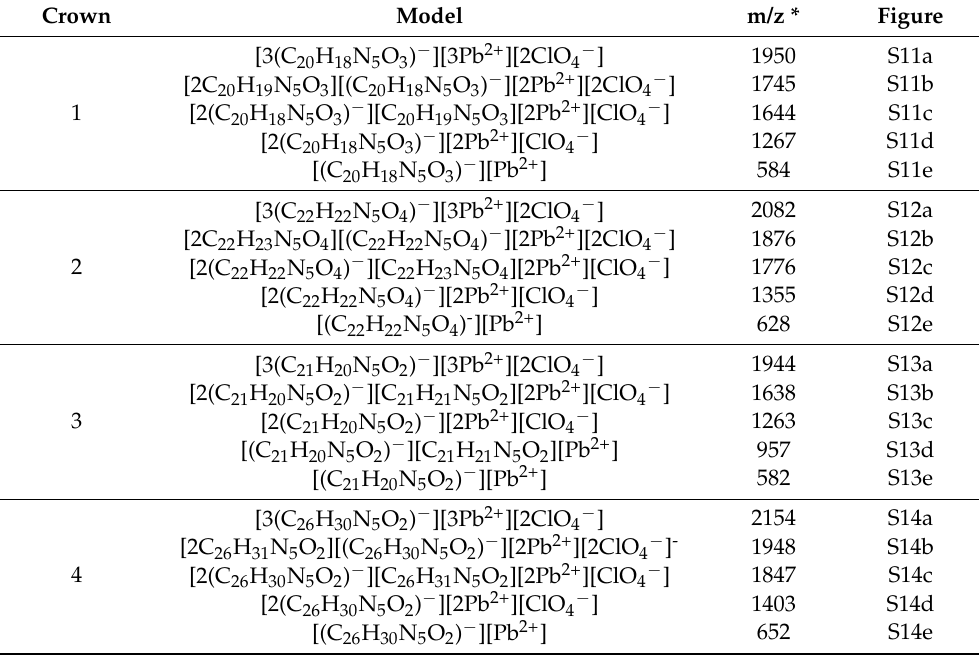
Figure 5. 1 H NMR spectrum of 2 (1.1 × 10 − 2 M) in the presence of lead(II) perchlorate, molar ratio of components— crown:lead(II) perchlorate 3:2 (DMSO-d 6 ). Table 1. Ionic species in ESI MS (positive mode) spectra of complexes of crowns 1 – 4 with lead(II). Crown Model m/z *